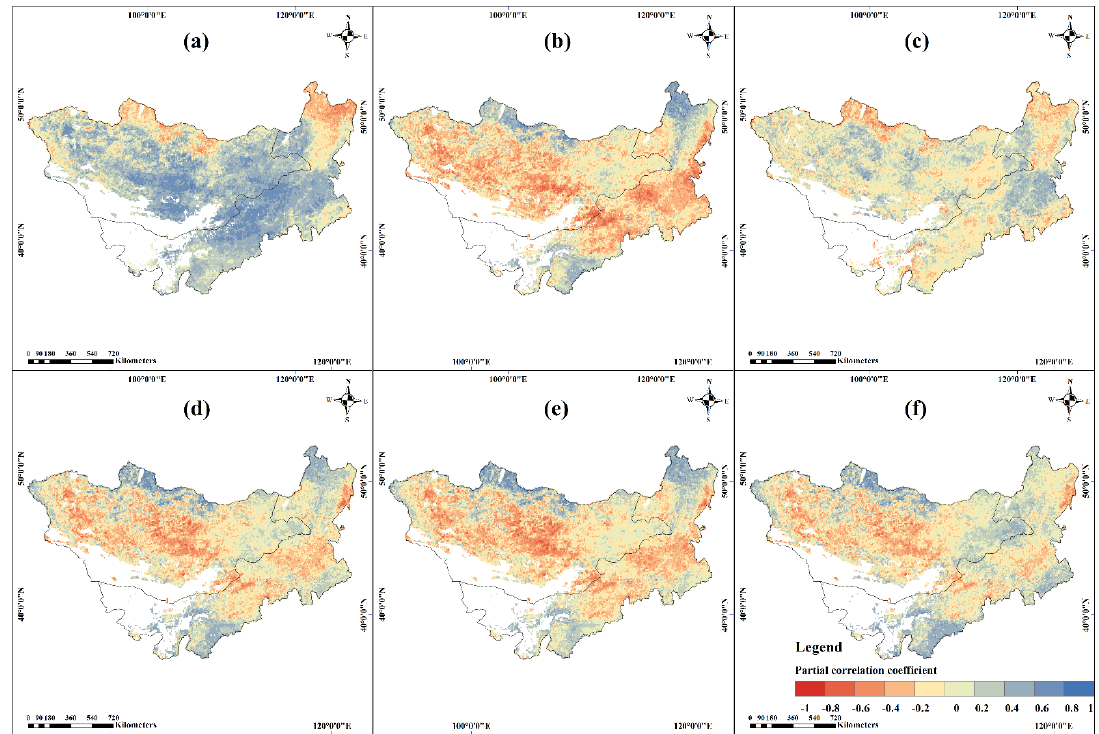
Figure 6. Spatial distribution of partial correlation coefficients between climatic factors and mean NDVI during the growing season of 1982 – 2015 in the Mongolian Plateau: ( a ) PRE, ( b ) PET, ( c ) SM,( d ) Tem, ( e ) Tmax, ( f ) Tmin . The spatial heterogeneity of correlation between climatic factors and NDVI gs repre- sents a general characteristic. Figure 7 presents the variation in the annual NDVI gs with